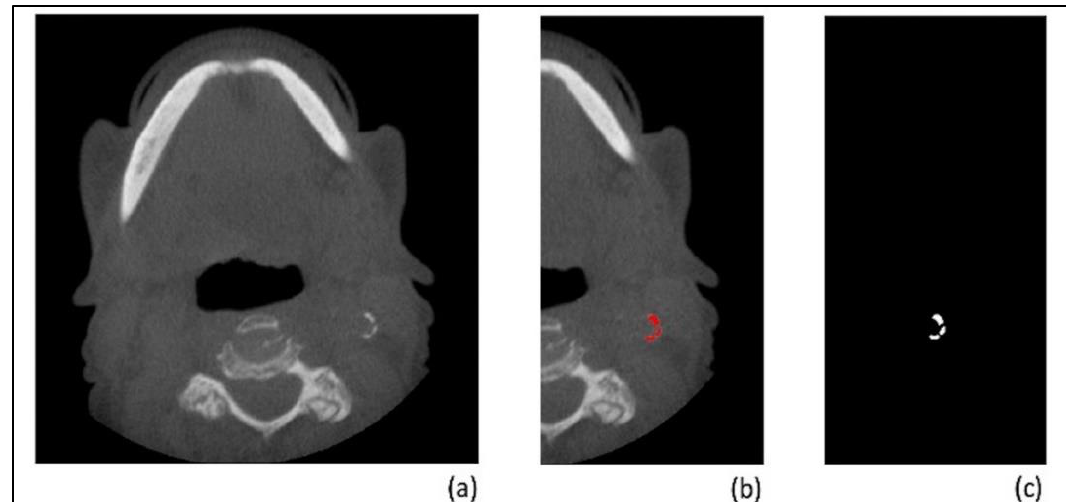
Figure 2. ( a ) an axial slice with a cervical carotid artery calcification. ( b ) the same image after the calcification has been annotated by the radiologist for training. ( c ) the black and white mask. ( b ) and ( c ) above are cropped horizontally for demonstration purposes—the actual masks have the same dimensions as the original image.